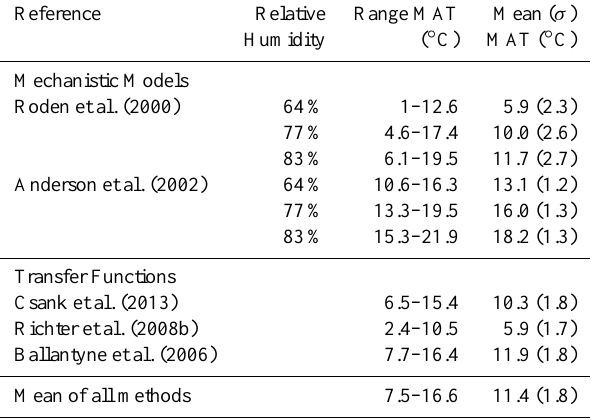
Table 2. Early Eocene Mean Annual Temperature (MAT) estimates based on δ 18 O of Piceoxylon cellulose. Several methods of tem- perature estimation in the literature were used, including mechanis- tic models (Roden et al., 2000; Anderson et al., 2002) and transfer functions (Csank et al., 2013; Richter et al., 2008b; Ballantyne et al., 2006) that predict δ 18 O sw from δ 18 O cellulose . MAT was derived from δ 18 O sw using a δ 18 O sw – temperature relationship developed for the Eocene (Fricke and Wing, 2004). Shown are references for model/function, relative humidity level (for mechanistic models), range (min–max) of MAT ( ◦ C), and mean (standard deviation) of MAT ( ◦ C) in chronology.